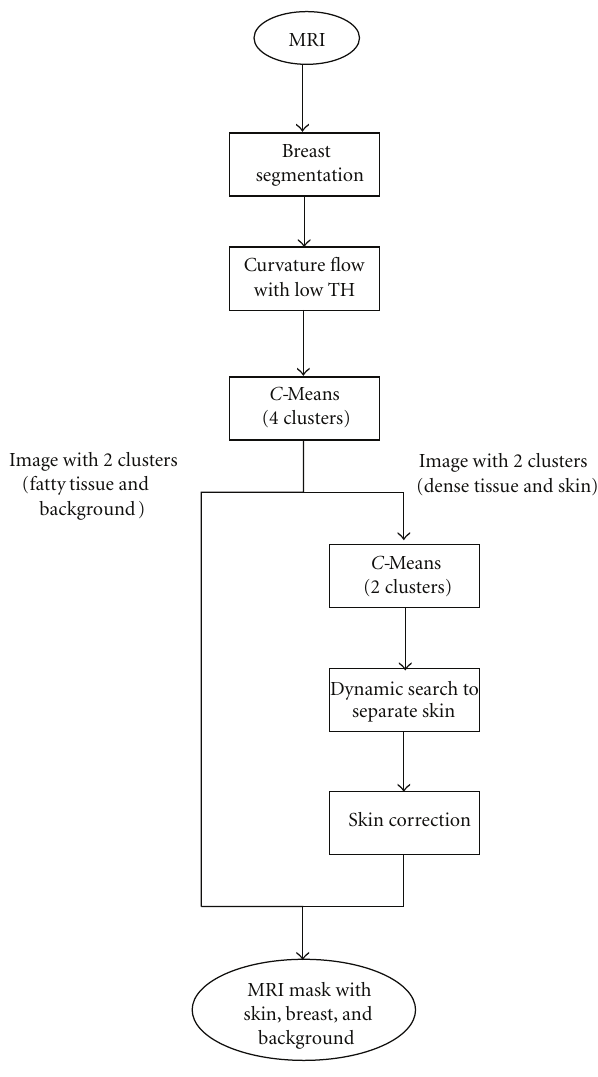
Figure 2: Skin segmentation